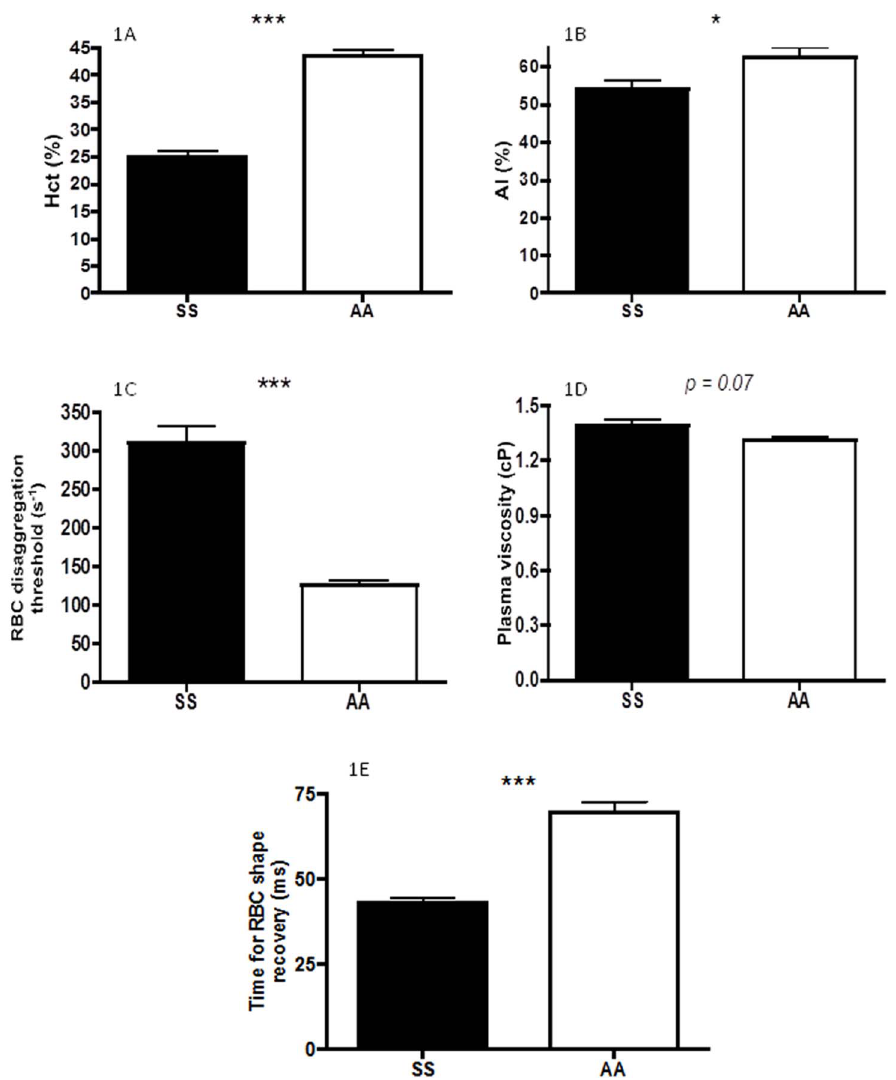
Fig. 1. A–E: Haematocrit (Hct; 1A), red blood cell aggregation index (AI; 1B), red blood cell aggregates strength (disaggregation threshold; 1C), plasma viscosity (1D) and time for red blood cell shape recovery (1E) in patients with sickle cell anaemia (SS) and healthy individuals (AA). Significant difference: *p , 0.05; ***p ,